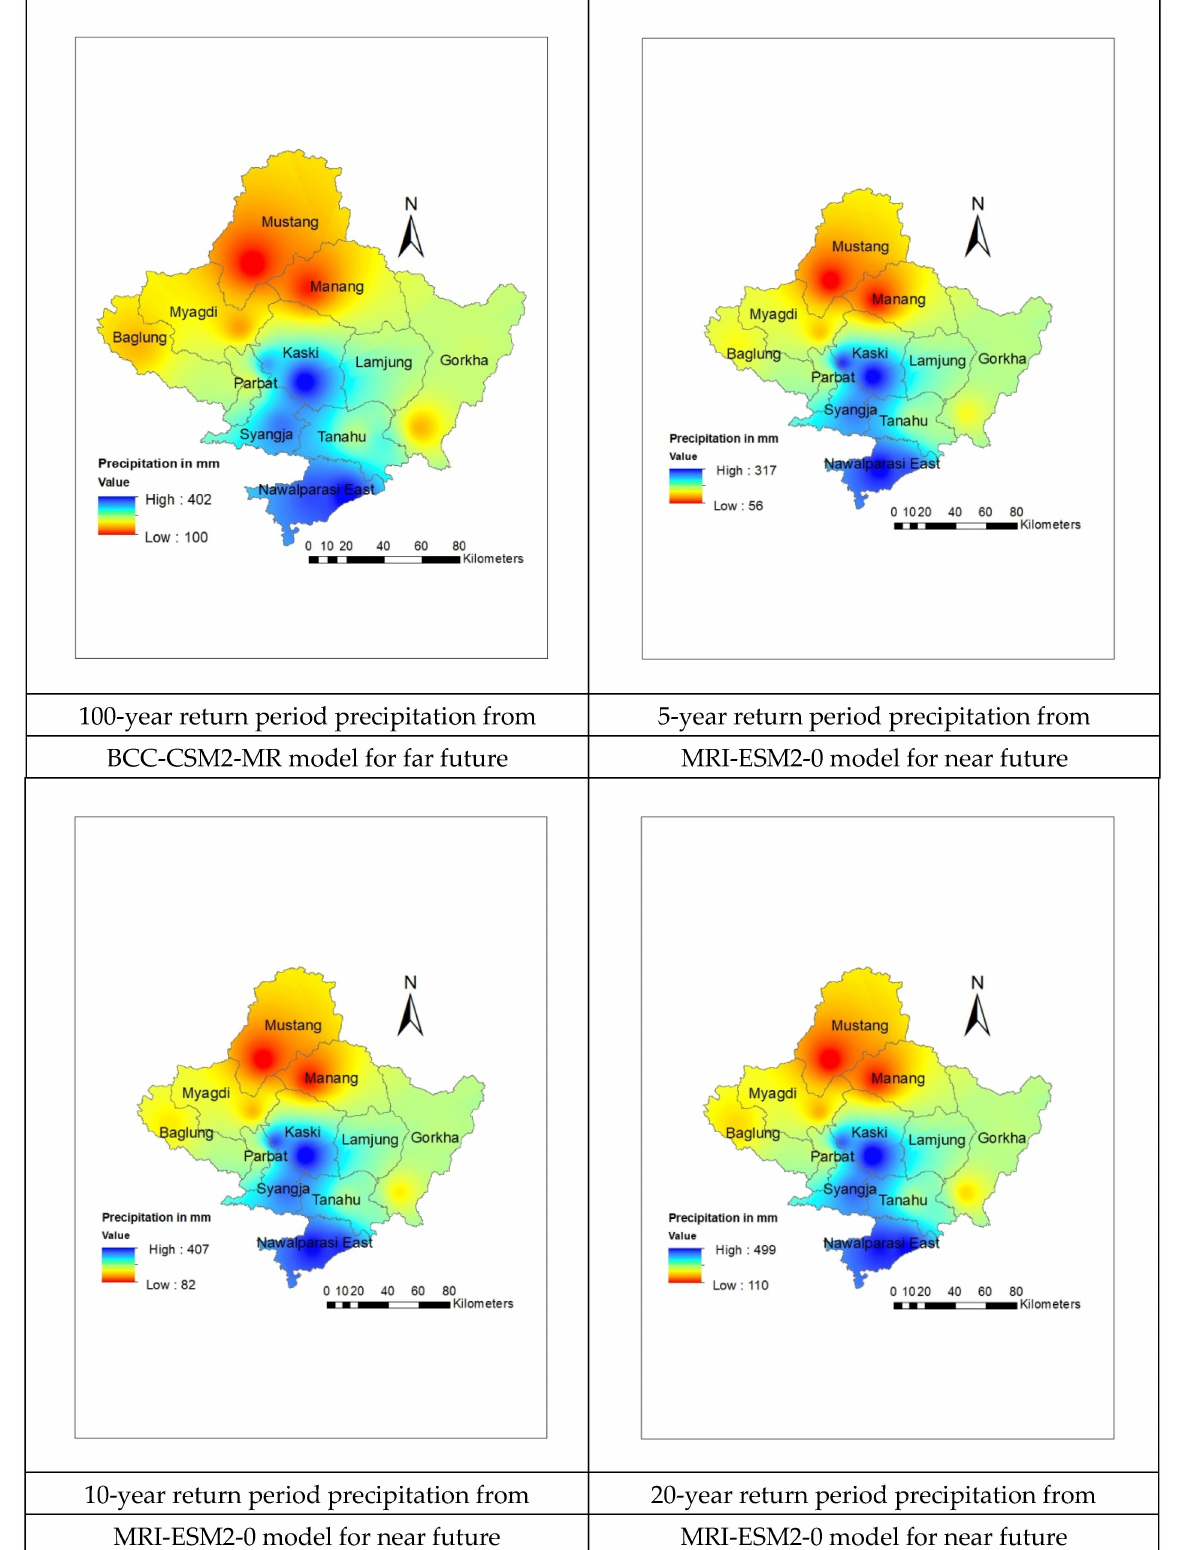
Figure A15. Cont